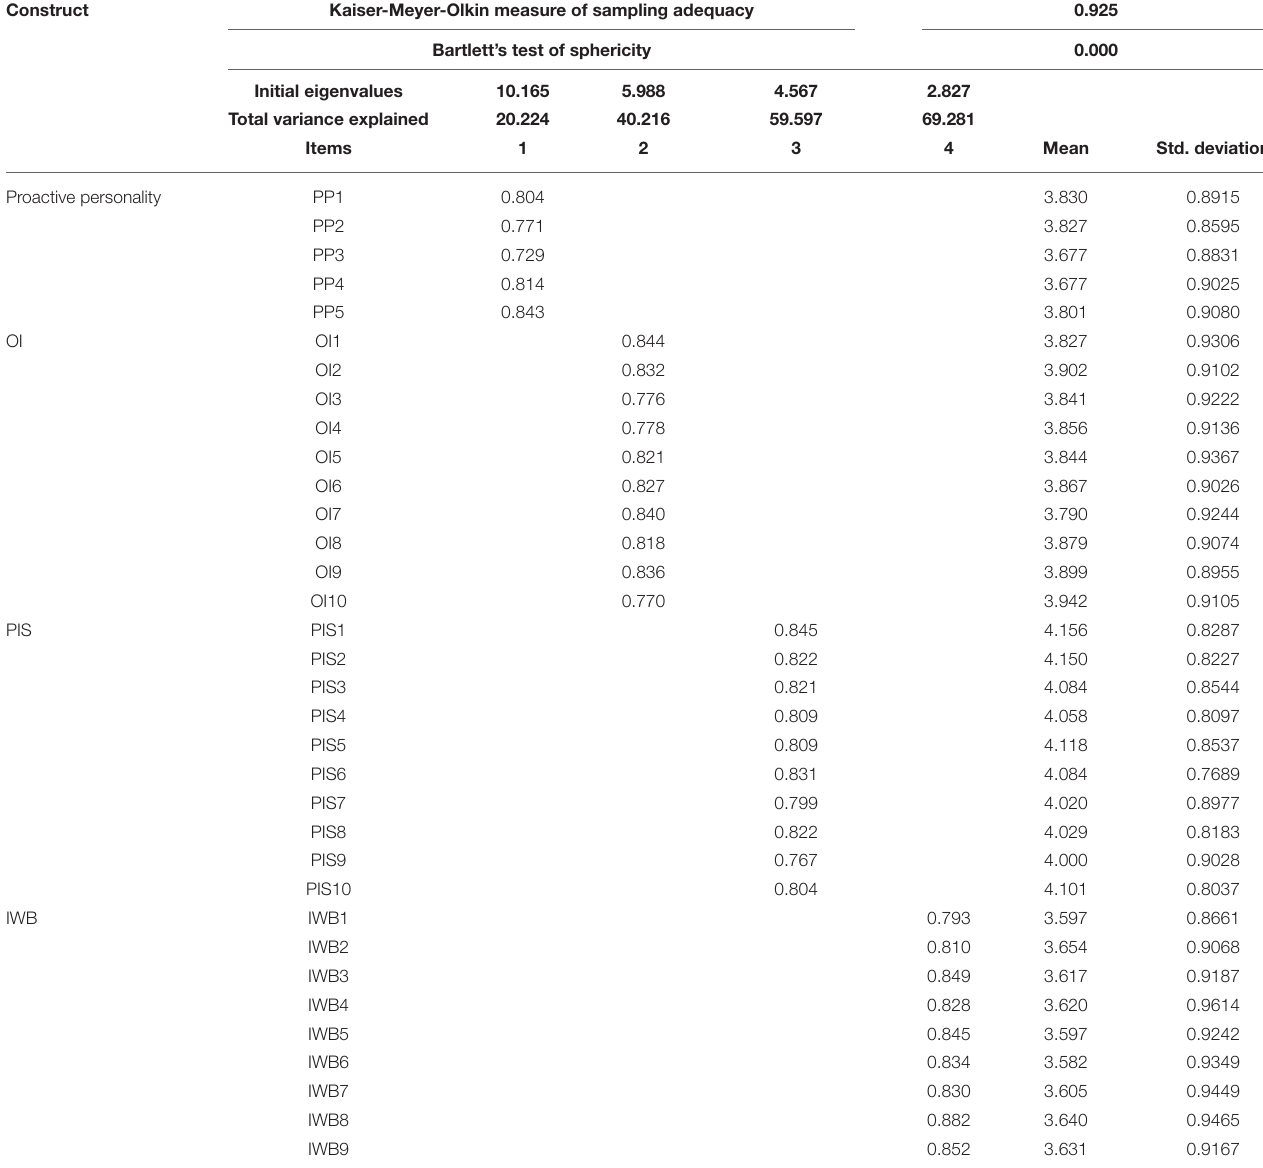
TABLE 4 | Rotated component